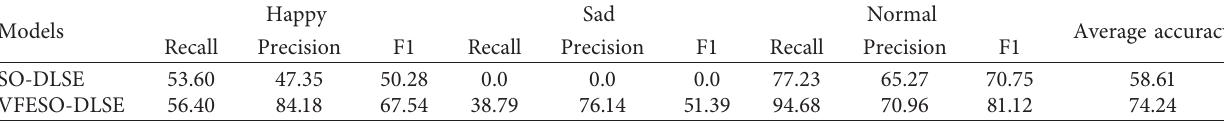
Table 5: The expression recognition performance of original data which are not equalized by CycleGAN (trained from scratch).